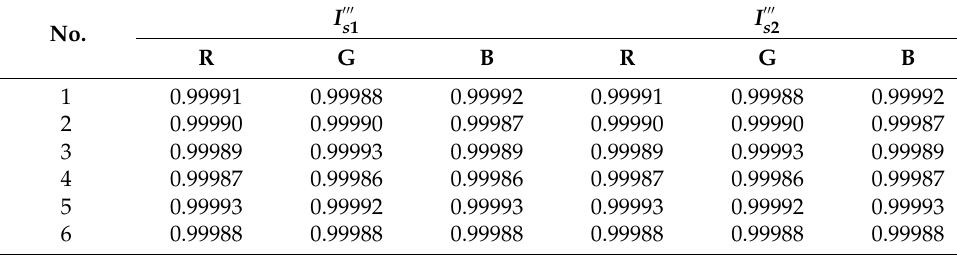
Table 14. The correlation coefficients of dual stego images in the Red, Green, and Blue